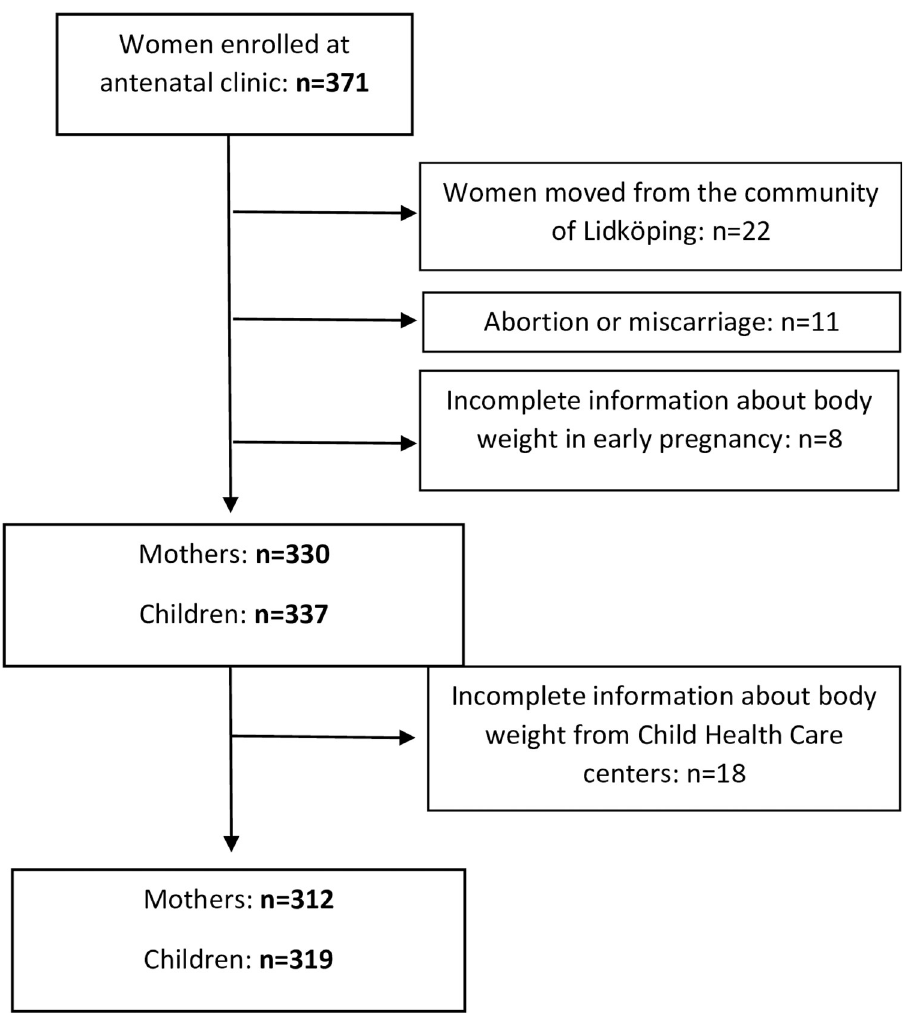
Fig 1. Flow chart of mother and child